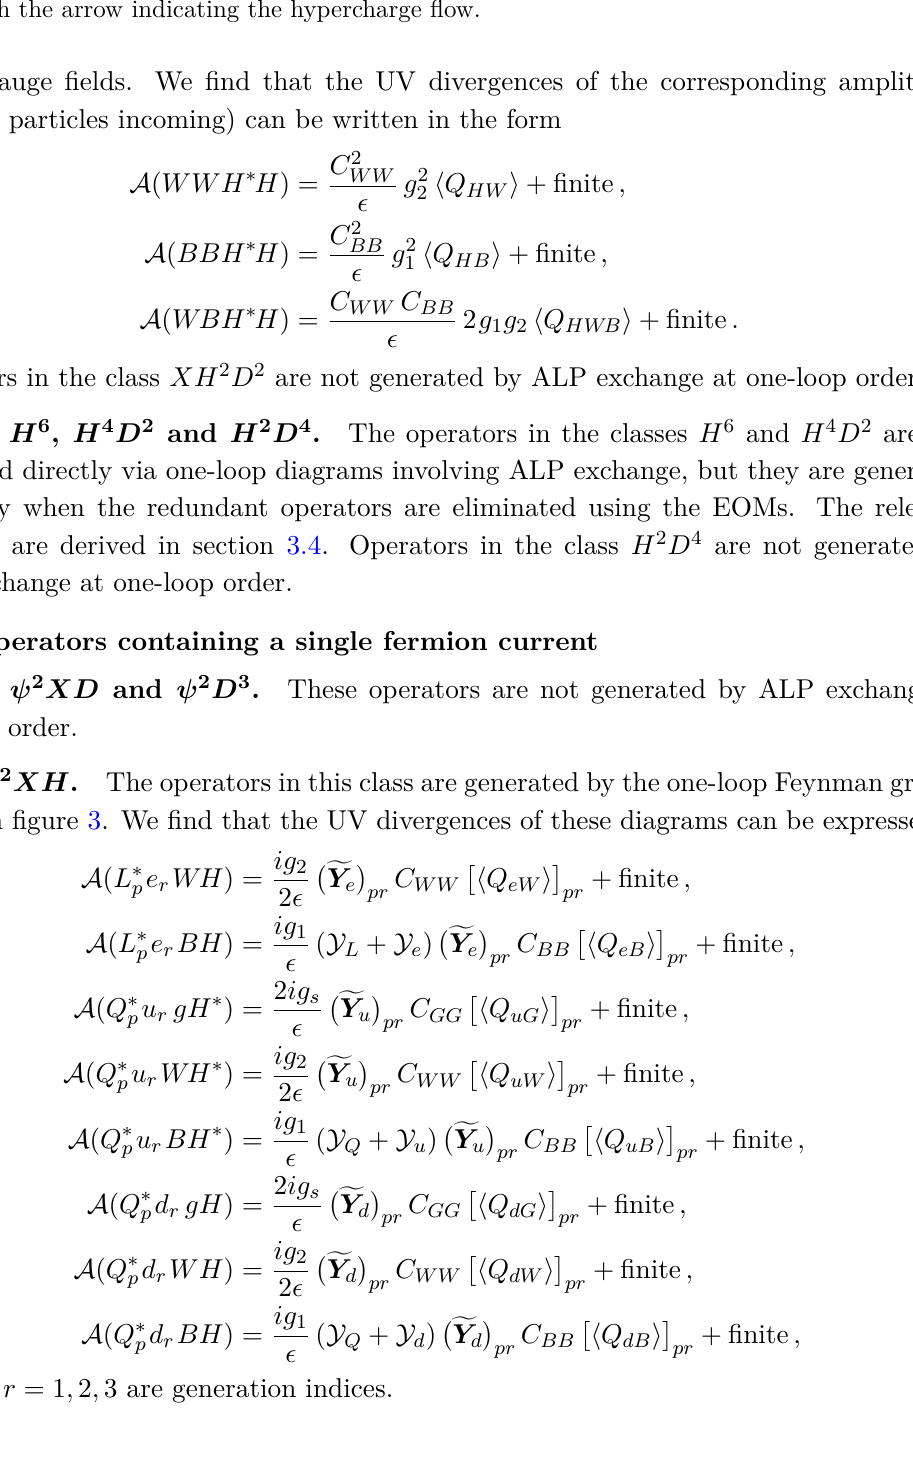
Figure 2 . Representative one-loop Feynman diagrams with ALP exchange (red dashed line), which require operators in the class X 2 H 2 as counterterms. Higgs doublets are represented by thick dotted lines, with the arrow indicating the hypercharge